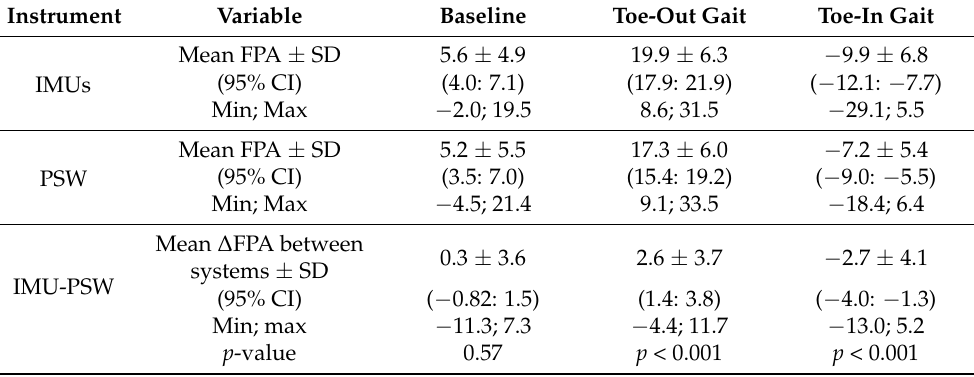
Table 2. Mean foot progression angle (FPA), standard deviation (SD), 95% confidence intervals (CI), minimum and maximum values and mean difference in FPA between the two systems in three conditions: baseline gait, toe-out gait, and toe-in gait. All values are in degrees for IMUs (Opal sensors) and the PSW (Zeno™ walkway). The calculations are based on 7974 steps by 20